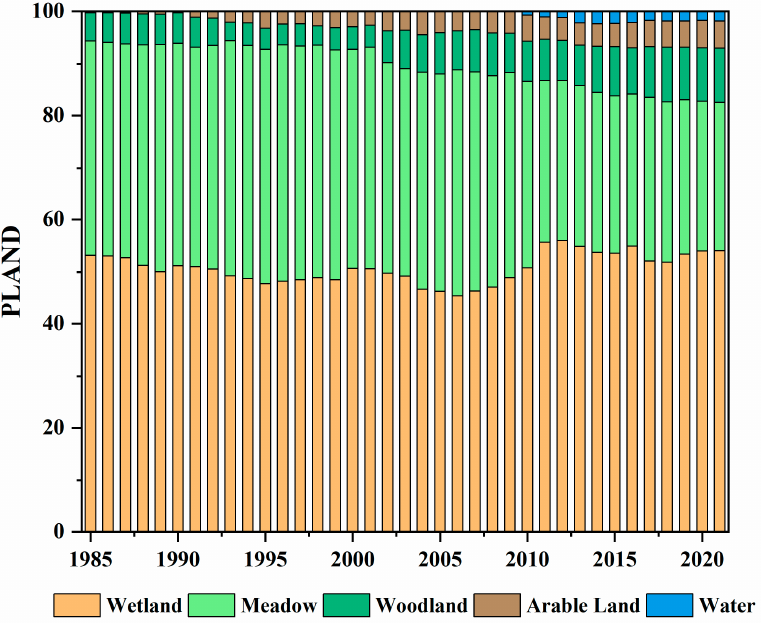
Figure 5. Change in PLAND values of the landscape types in the HNNR from 1985 to 2021.